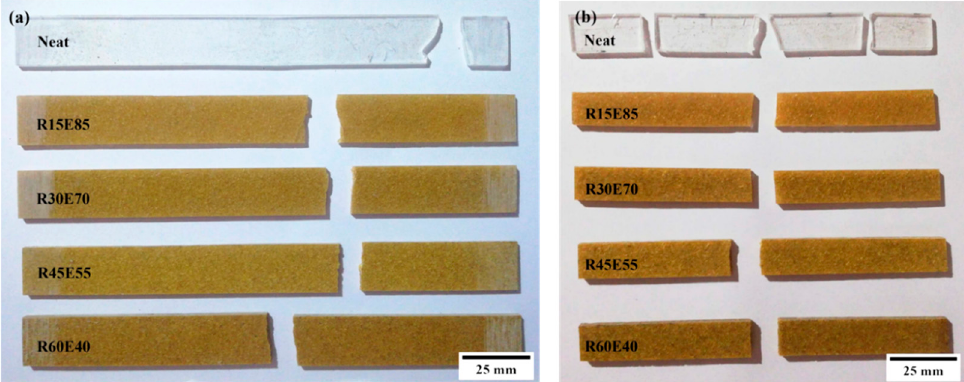
Figure 12. Fractured test samples subjected to ( a ) tensile ( b ) flexural test.